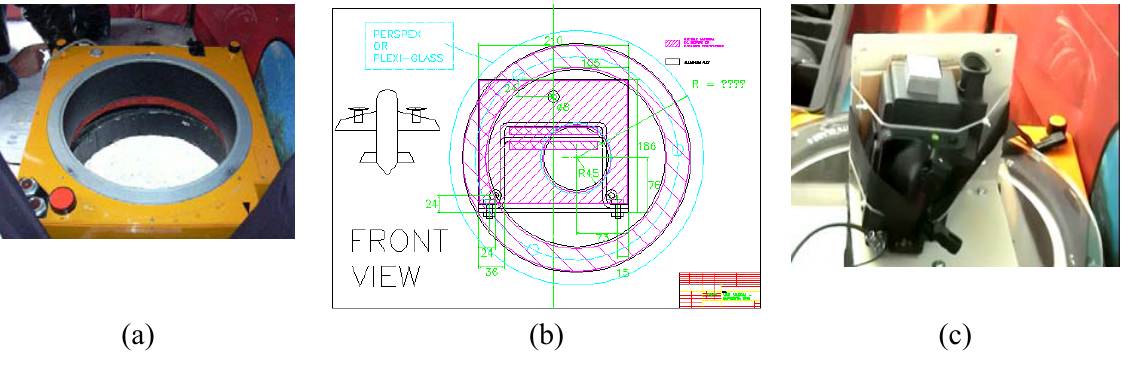
Figure 5 . (a) Camera opening at the bottom of the aircraft CESSNA 310Q using an inertial gyroscopic platform GSM300, (b) Design for camera fit to the camera opening at the bottom of the aircraft, (c) Camera and IMU devices rigidly attached.